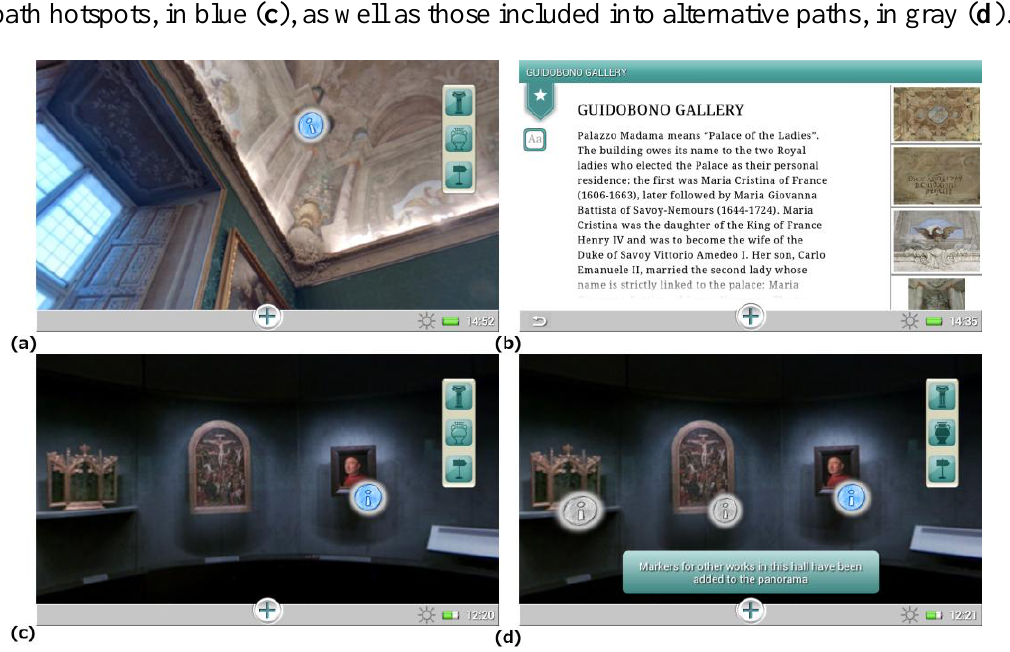
Figure 6. An interactive hotspot ( a ) and its related content ( b ); a panoramic image showing the path hotspots, in blue ( c ), as well as those included into alternative paths, in gray ( d ).